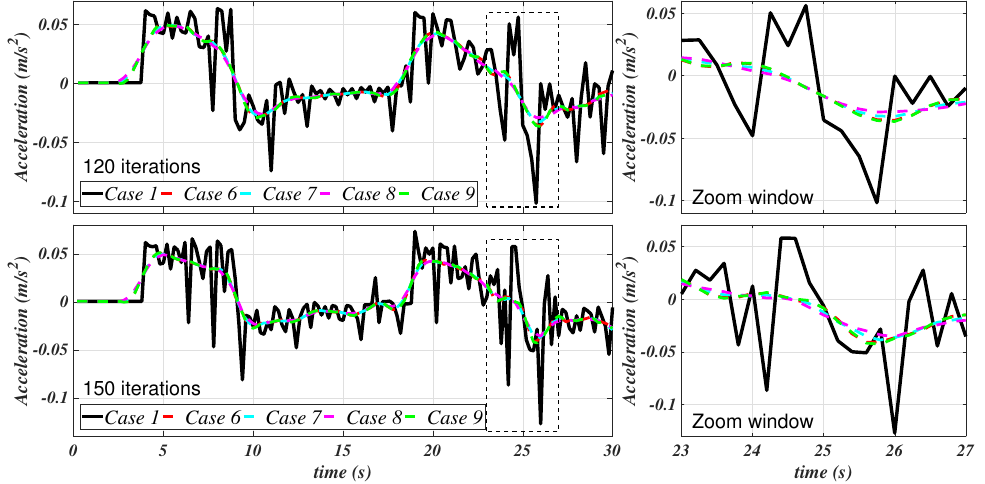
Figure 9. Double filtered acceleration signals in positive motion along b x